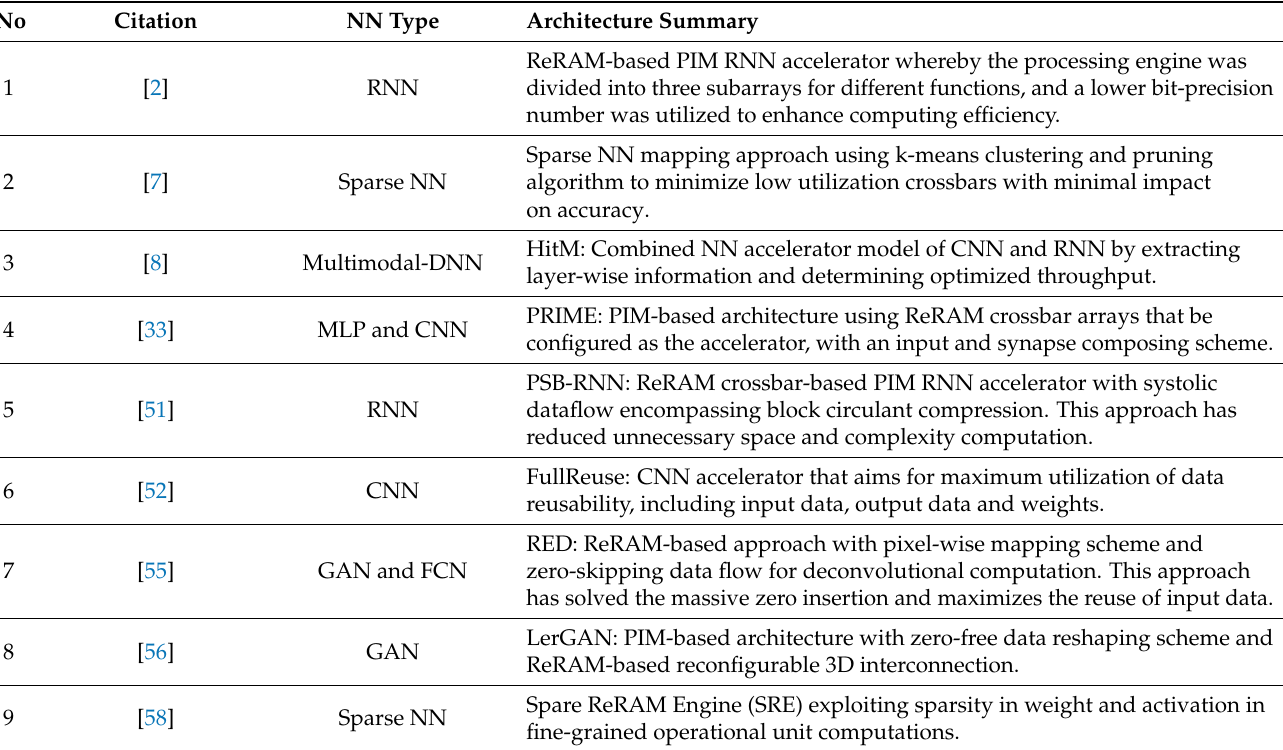
Table 2. Research trend